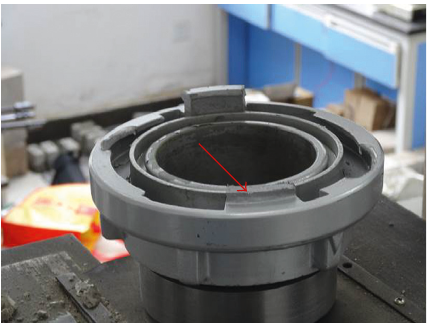
Figure 38: Fracture morphology of the movable end of the joint.